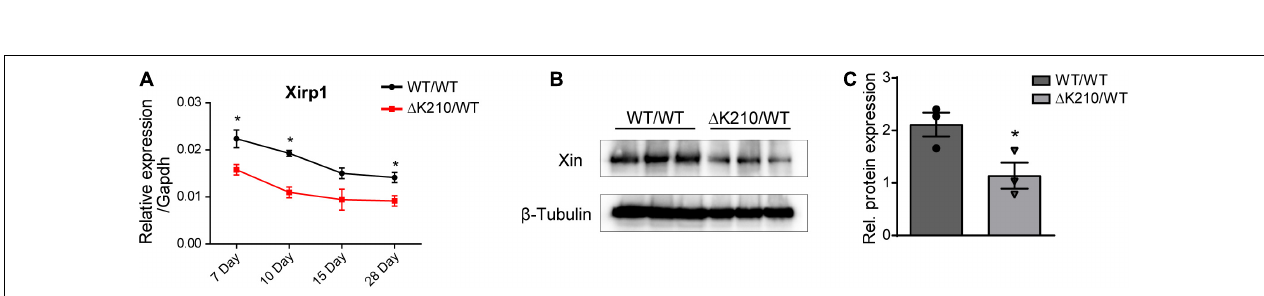
FIGURE 4 | Expression of Xirp1 in the TNNT2 - (cid:49) K210 mice hearts. (A) Changes in temporal mouse Xirp1 expression in wild type and TNNT2 - (cid:49) K210 mutant mice. (B) Western blot analysis showed decreased level of XINprotein in Day 7 TNNT2 - (cid:49) K210 mice hearts. (C) , Quantification of western blot signals in (B) and normalized to the loading control ( β -Tubulin). Data are represented as mean ± SEM. * P < 0.05.